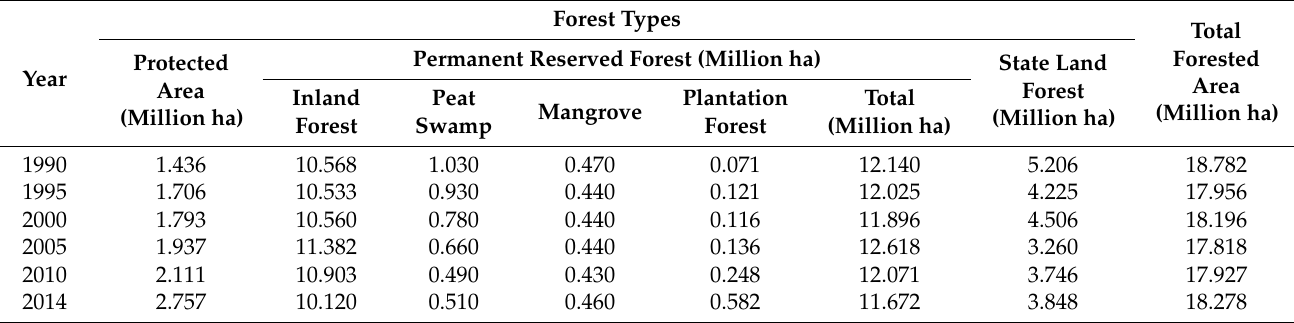
Table 1. Total forested areas by different forest types in Malaysia